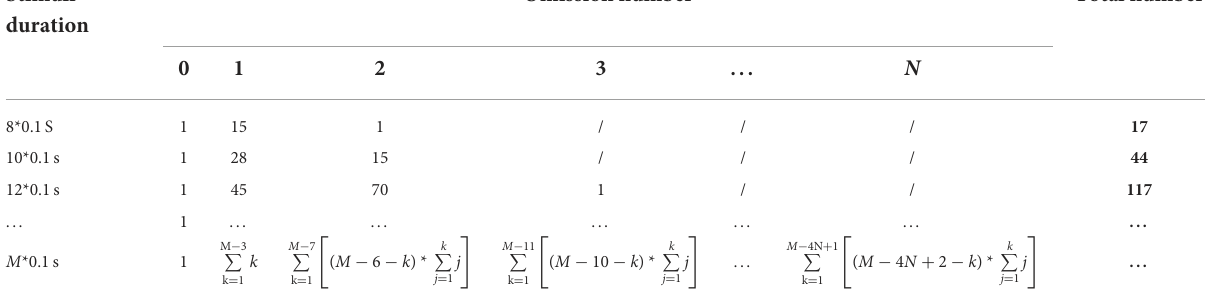
TABLE 1 The number of stimuli sequences that can be generated in the different stimuli duration when different omission numbers are used under the extended MTFSC protocol, with only one stimulus frequency used. Stimuli Omission number Total duration